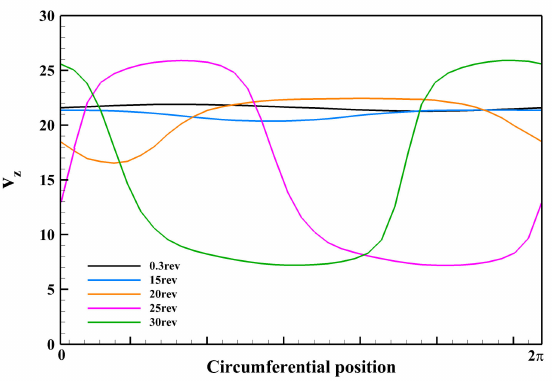
Figure 11. The circumferential distribution of axial velocity at the tip of the leading edge of the rotor at several time